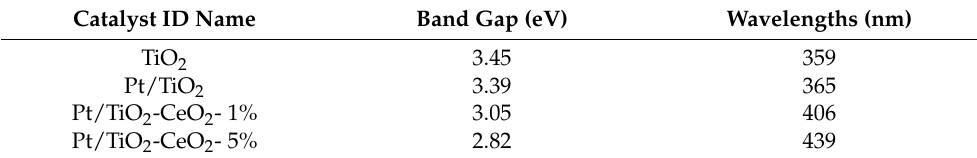
Table 3. Band Gap Energy and Wavelengths.